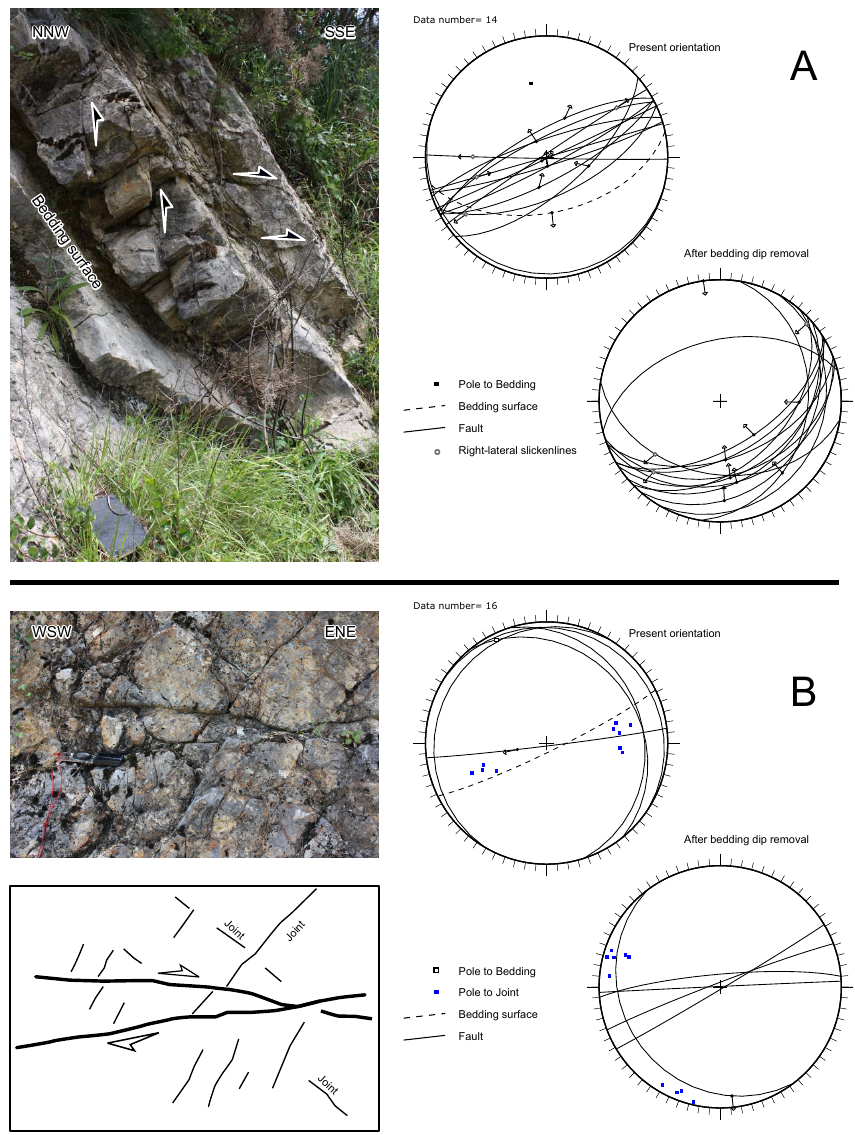
Fig. 14. Mesostructures and corresponding stereoplots of two outcrops in the southern block of the Cabu ´ erniga Fault near its western termination. (A) Tilted reverse faults. (B) Tilted right-lateral fault system postdating an earlier extensional system formed by two sets of mutually perpendicular